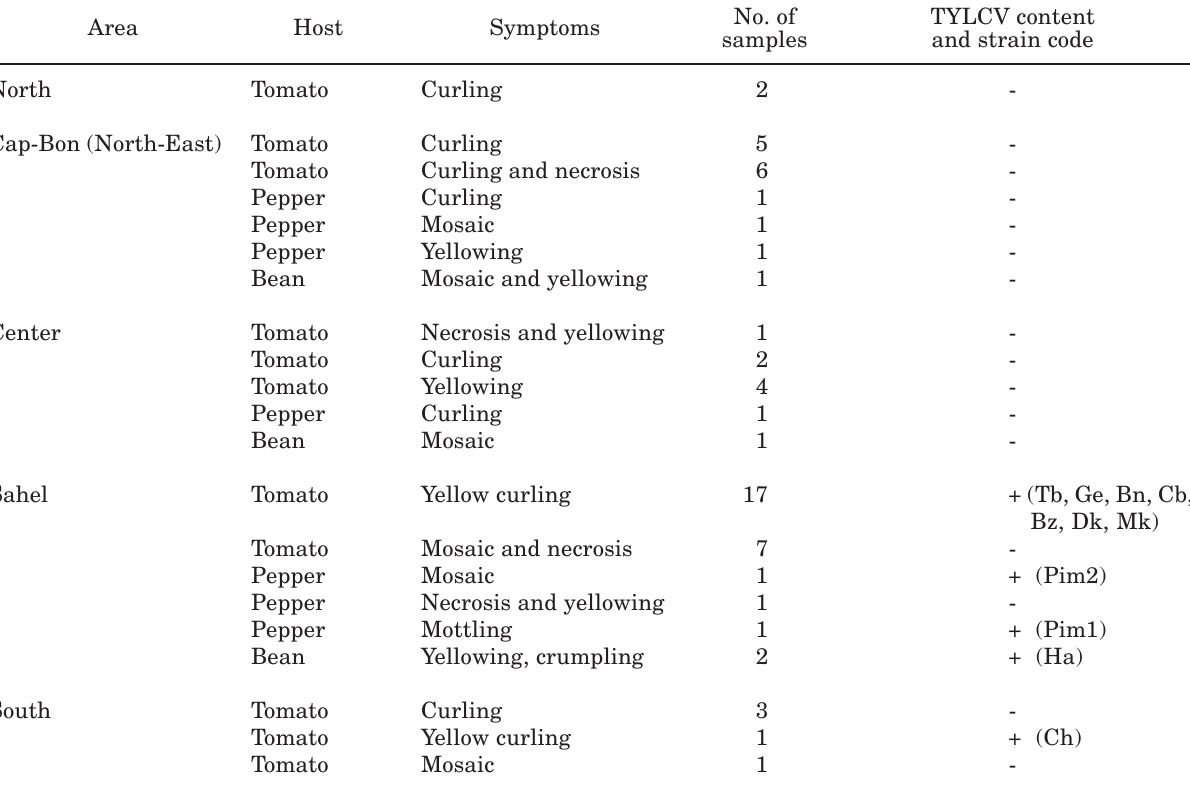
Table 1. Origin, field symptoms and TYLCV content of collected